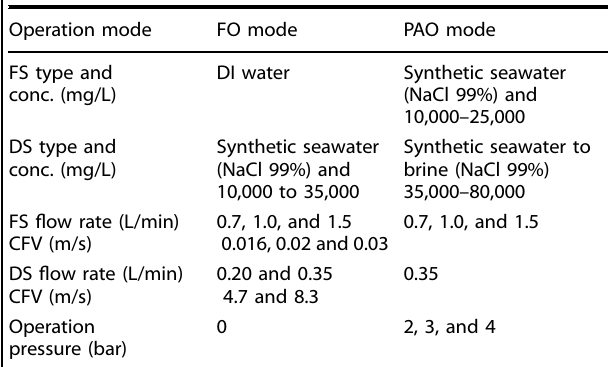
Table 3. Operation